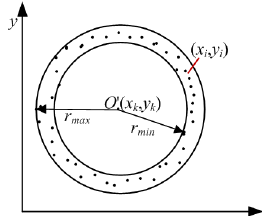
Figure 9. Schematic of roundness deviation evaluation.